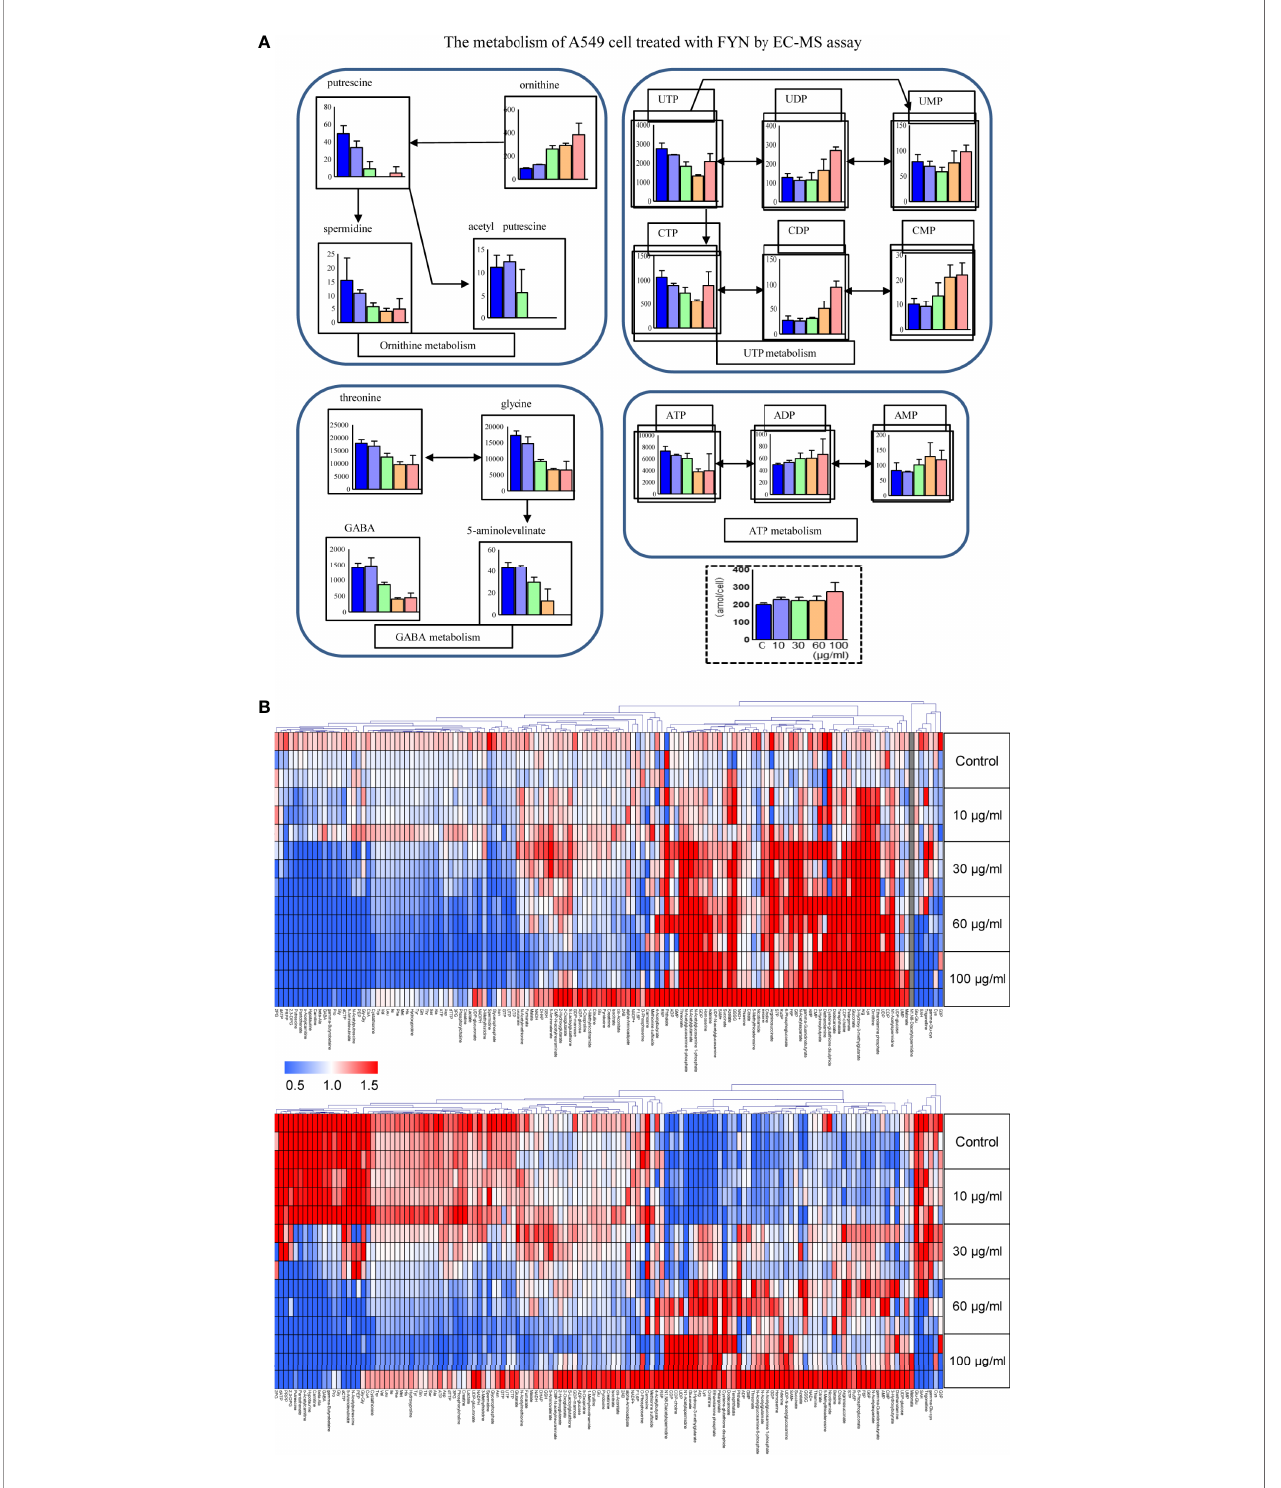
FIGURE 6 | Metabolomics analyses of A549 cells treated with FYN. (A) Changes in common cellular metabolites in A549 cells were measured using CE-MS assay after the indicated treatments. A549 cells were treated with different concentrations of FYN (10, 30, 60, 100 m g/ml) for 24 h, and CE-MS was performed to measure cell metabolites (amol/cell). (B) Metabolome heat map. Blue, white, and red indicate the fold changes of 0, 1, and 2, respectively, compared to the average of control samples. For undetectable substances in the control group, the half value of the minimum concentration of all samples was